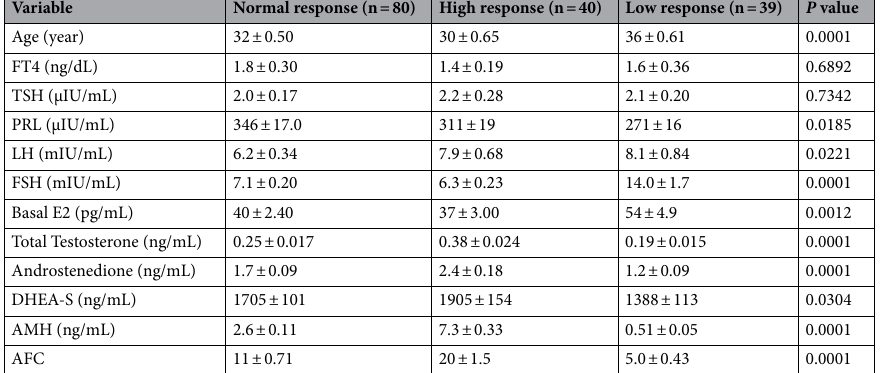
Table 1. Statistical evaluation of the demographic, hormonal and clinical characteristics of women presenting at an infertility clinic. n = 159. Grouping according to normal, high, and low ovarian reserve. ANOVA, mean ± standard deviation. Statistically significant if P value < 0.05. FT4 free thyroxine 4, TSH thyroid stimulating hormone, PRL prolactin, LH luteinizing hormone, FSH follicle stimulating hormone, Basal E2 basal estradiol, DHEA-S dehydroepiandrosterone sulfate, AMH anti-Müllerian hormone, AFC antral follicle